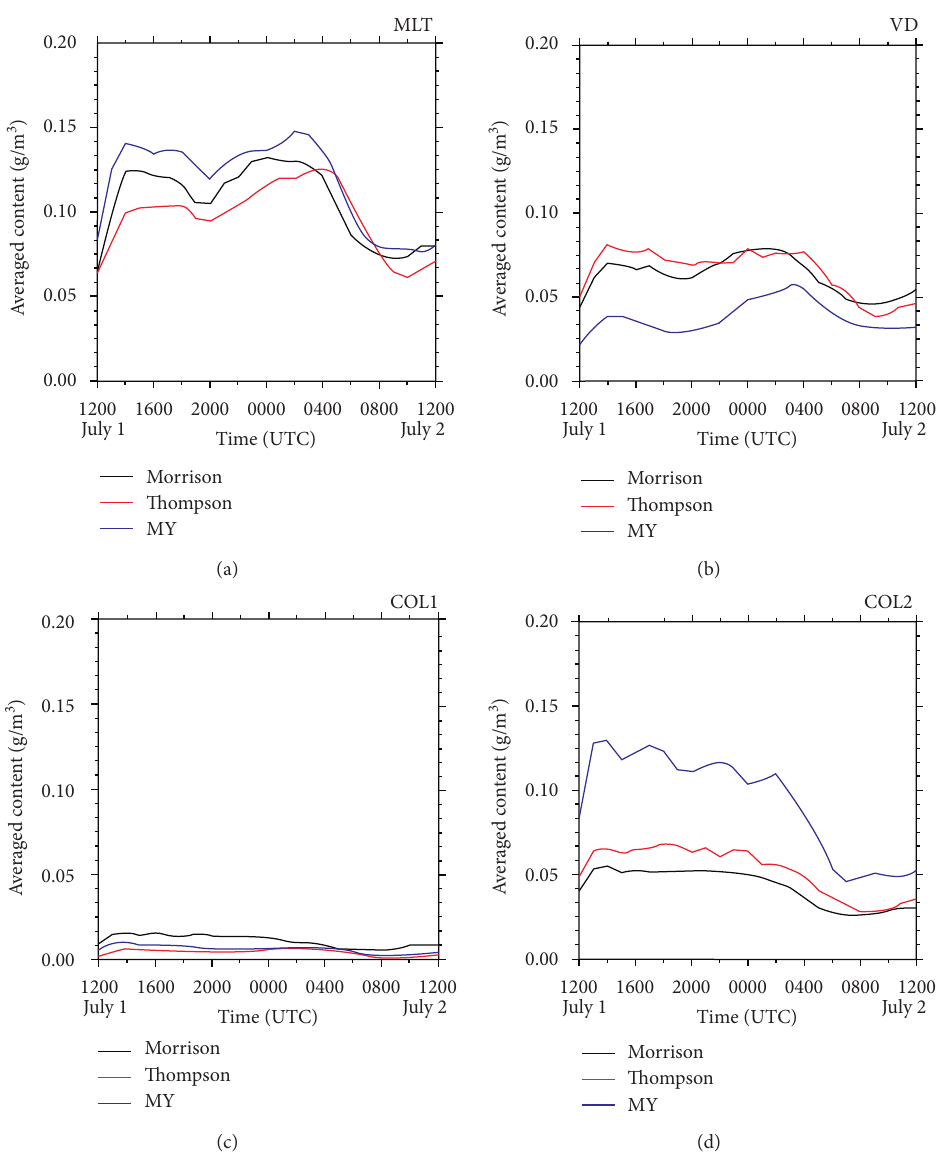
Figure 12: Time series of the mean contents of sink and source terms of ice-phase hydrometeors in heavy rainfall areas (R greater than 50mm/24 (h) from 1200 UTC on 1 July to 1200 UTC on 2 July 2016: (a) melting of ice-phase hydrometeors; (b) deposition of vapor; (c) riming (for raindrops); (d) riming (for cloud droplets). The black, red, and blue lines indicate the Morrison, Thompson, and MY schemes, respectively. Table 4: The same as Table 2 except for the melting of ice-phase hydrometeors (Mlt), deposition (Dep), and riming of raindrops (Col1) and cloud droplets (Col2) by ice-phase hydrometeors. “—” indicates a negligible change. Morrison Thompson MY Time